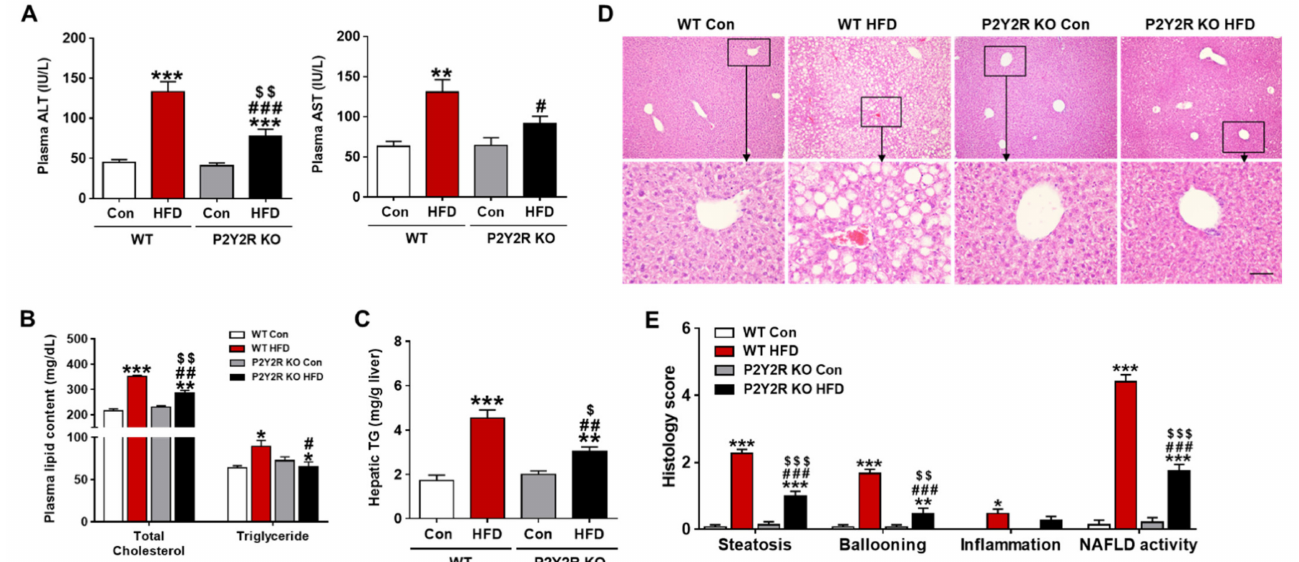
Figure 2. P2Y2R deficiency attenuates hepatic steatosis and cellular injury in HFD-fed mice. ( A ) Plasma ALT and AST levels were measured to assess hepatic injury ( n = 8). ( B , C ) Plasma total cholesterol and triglyceride ( n = 8), and hepatic triglyceride levels were determined to assess lipid accumulation ( n = 5). ( D ) Representative images of H&E staining from liver sections were presented for evaluating hepatic steatosis and pathological changes ( n = 5). ( E ) Hepatic steatosis, ballooning, and lobular inflammation were semi-quantitatively evaluated from H&E-stained sections to determine NAFLD activity score (NAS) as detailed in materials and methods. Data are presented as the mean ± SEM. One-way ANOVA was used for statistical analysis followed by Bonferroni’s multiple comparison test. * p < 0.05, ** p < 0.01, *** p < 0.001 vs. WT control mice; and # p < 0.05, ## p < 0.01, ### p vs. WT HFD mice; and $ p < 0.05, $$ p < 0.01, $$$ p < 0.001 vs. KO control mice. Scale bar, 100 µ